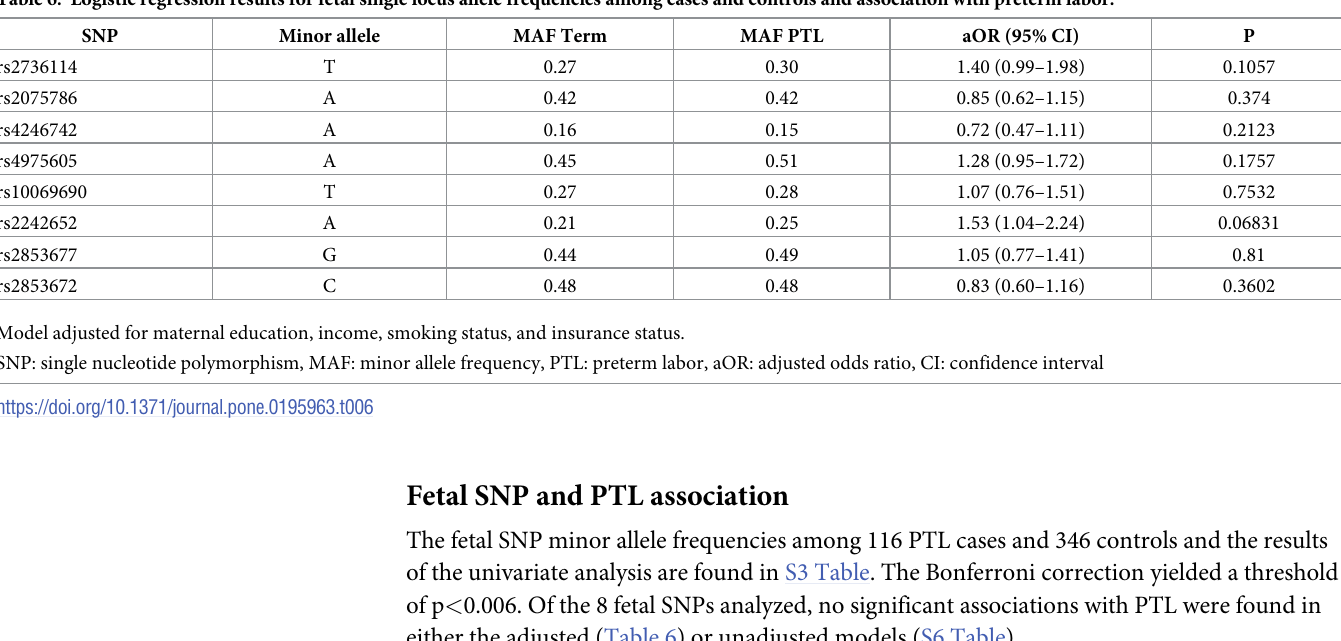
The fetal SNP minor allele frequencies among 116 PTL cases and 346 controls and the results of the univariate analysis are found in S3 Table. The Bonferroni correction yielded a threshold of p < 0.006. Of the 8 fetal SNPs analyzed, no significant associations with PTL were found in either the adjusted (Table 6) or unadjusted models (S6 Table).